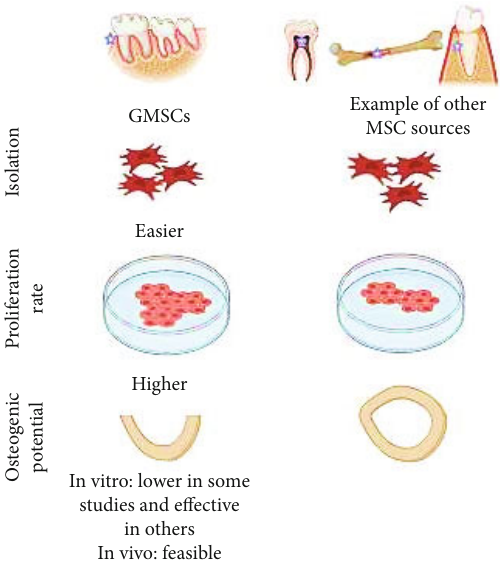
Figure 4: Schematic diagram represents the main fi nding of the current review.